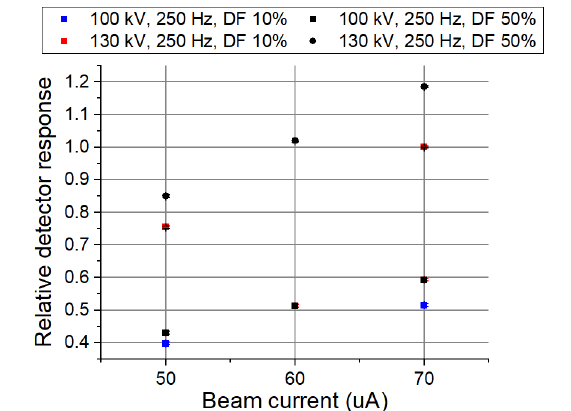
Fig. 10 Cadmium-covered detector response to P-385 D-D neutron generator operated in pulsed mode demonstrating the neutron output dependence